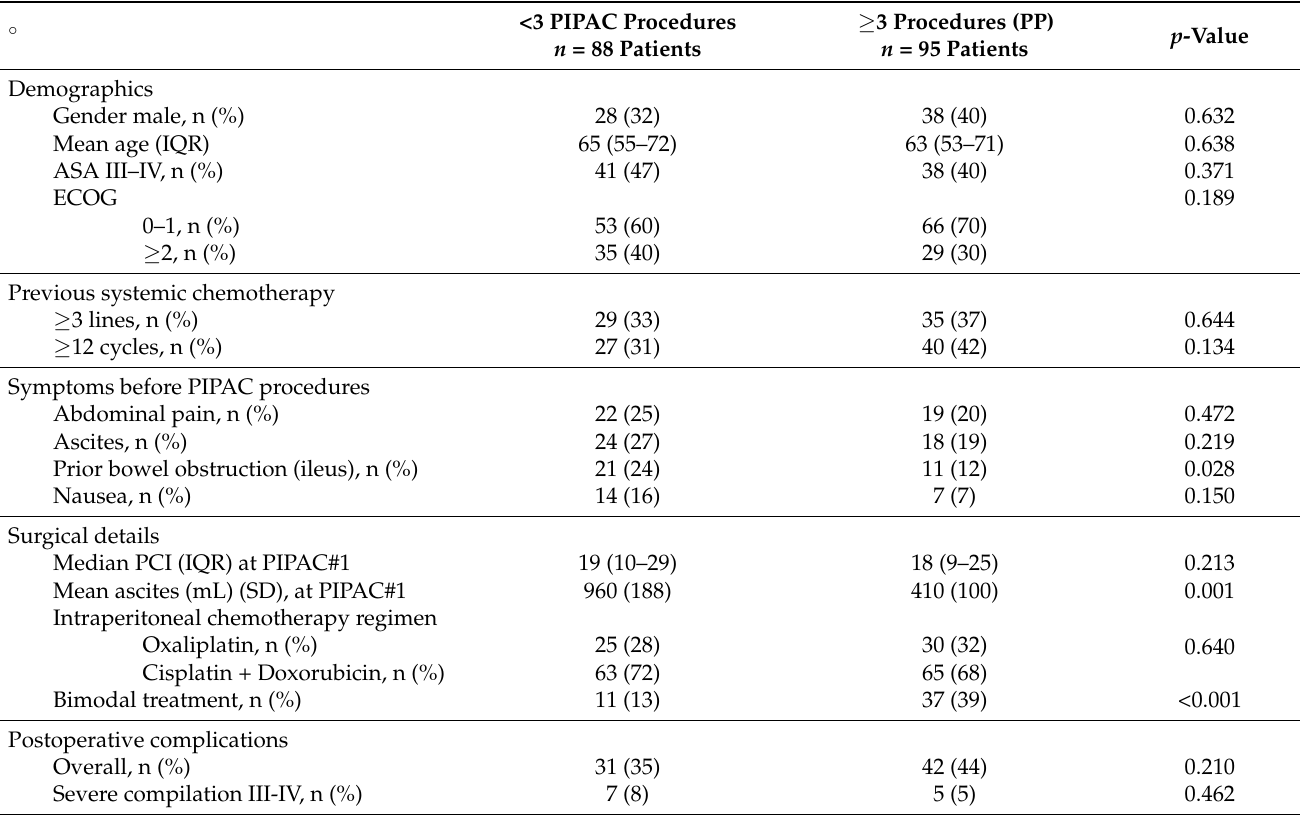
Table 1. Potential predictors for completion of PIPAC treatment.